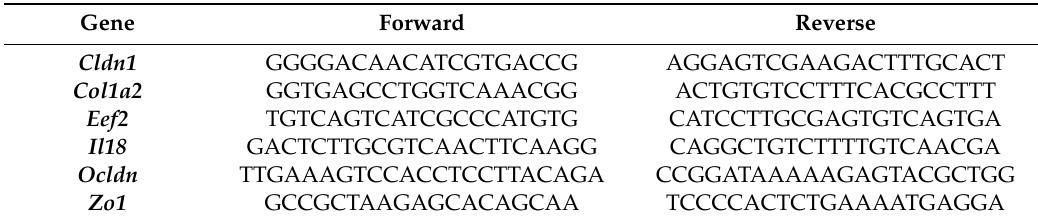
Table 2. Mouse primers